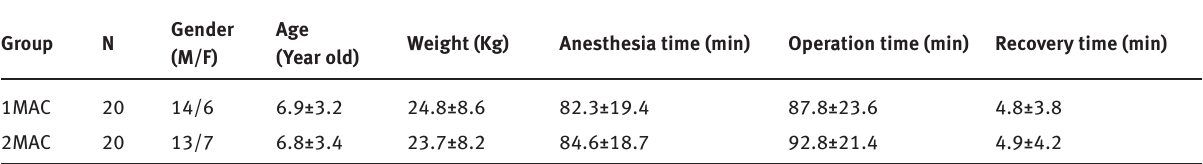
Table 1: Comparison between the two group patients in general situation and operation condition